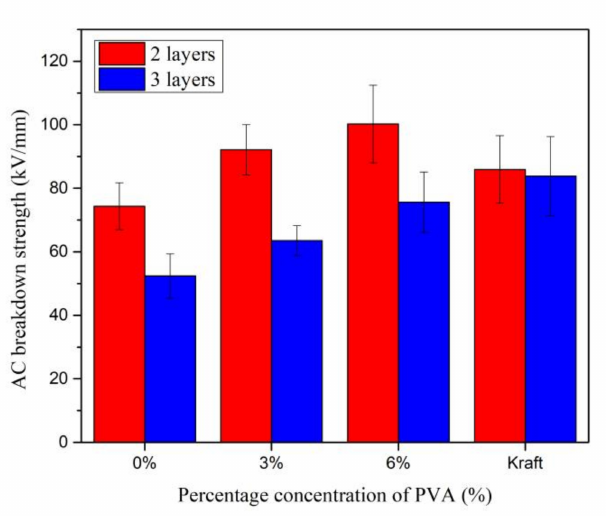
Figure 26. AC Breakdown strength of Kenaf and Kraft papers at di ff erent weight percentage concentration of